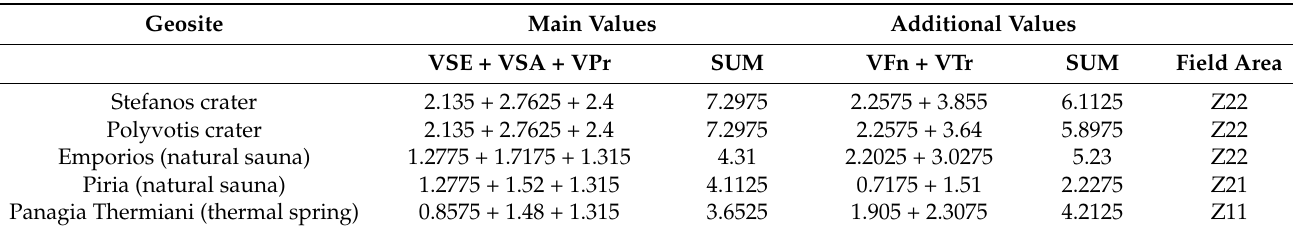
Table 8. Final results of the application of the M-GAM